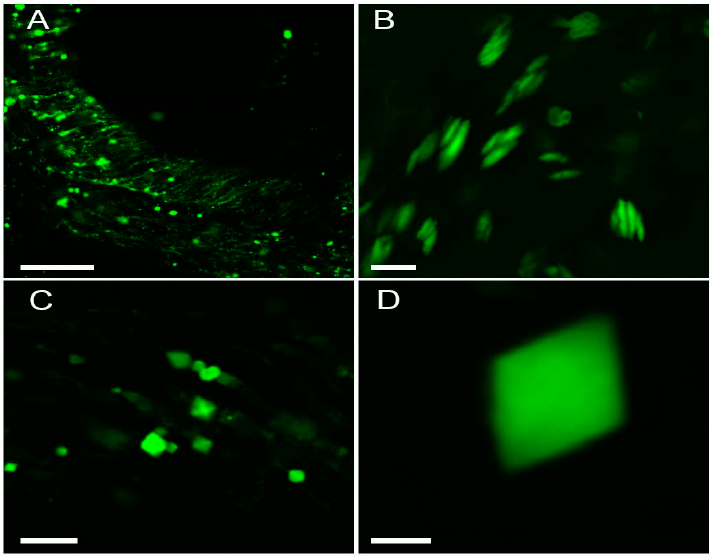
Figure 4. Confocal microscopy of live Zoanthus tentacle tissues. Green fluorescence images (excitation 488 nm, detection 500–535 nm) of representative structures (cells with diffuse signal, aggregates and crystals) at different zoom magnification are shown. Scale bars: ( A ), − 50 µm; ( B ) and ( C ), − 10 µm; ( D ), − 2 µm.